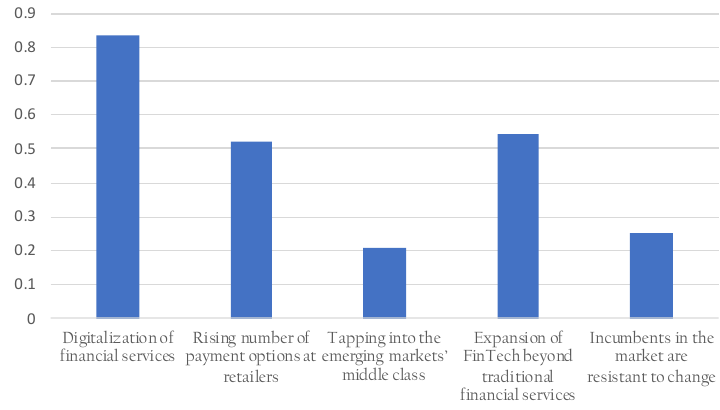
Figure 7. Triggers behind FinTech